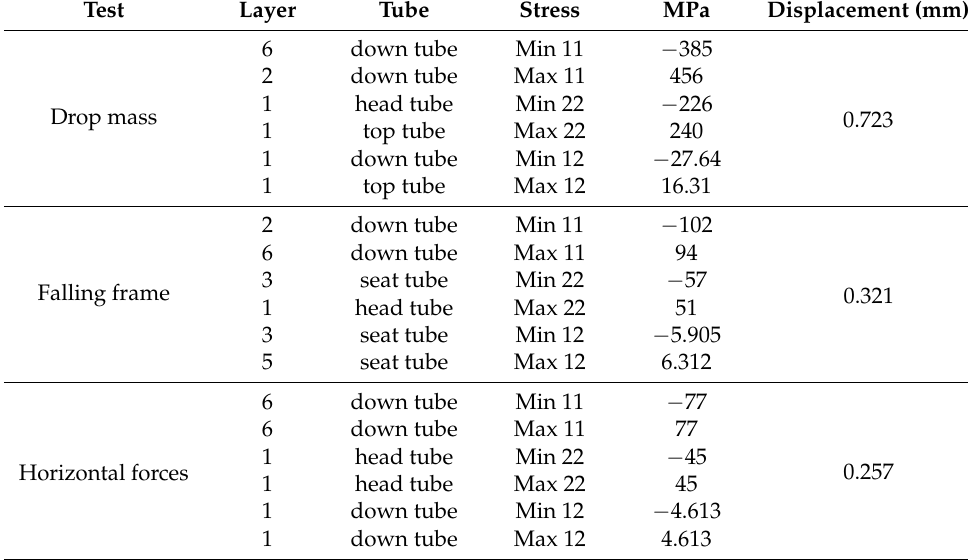
Table 26. Stress and displacement results of stacking scenario